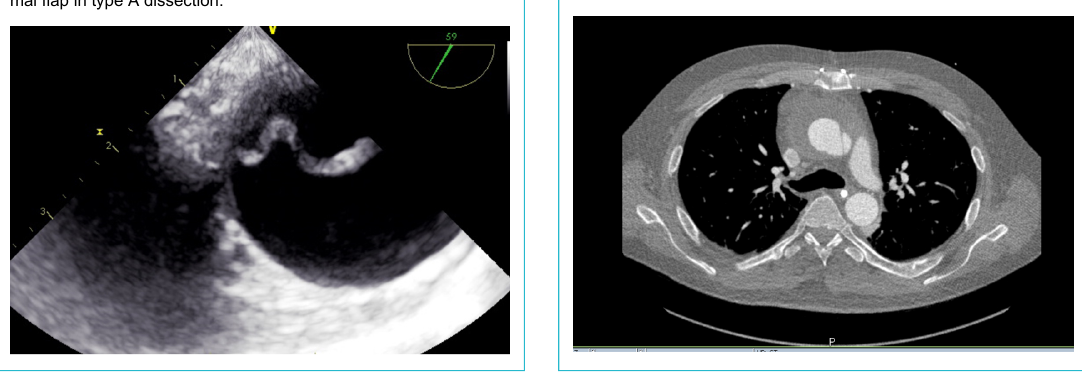
Figure 3: Computed tomography scan of type A dissection with